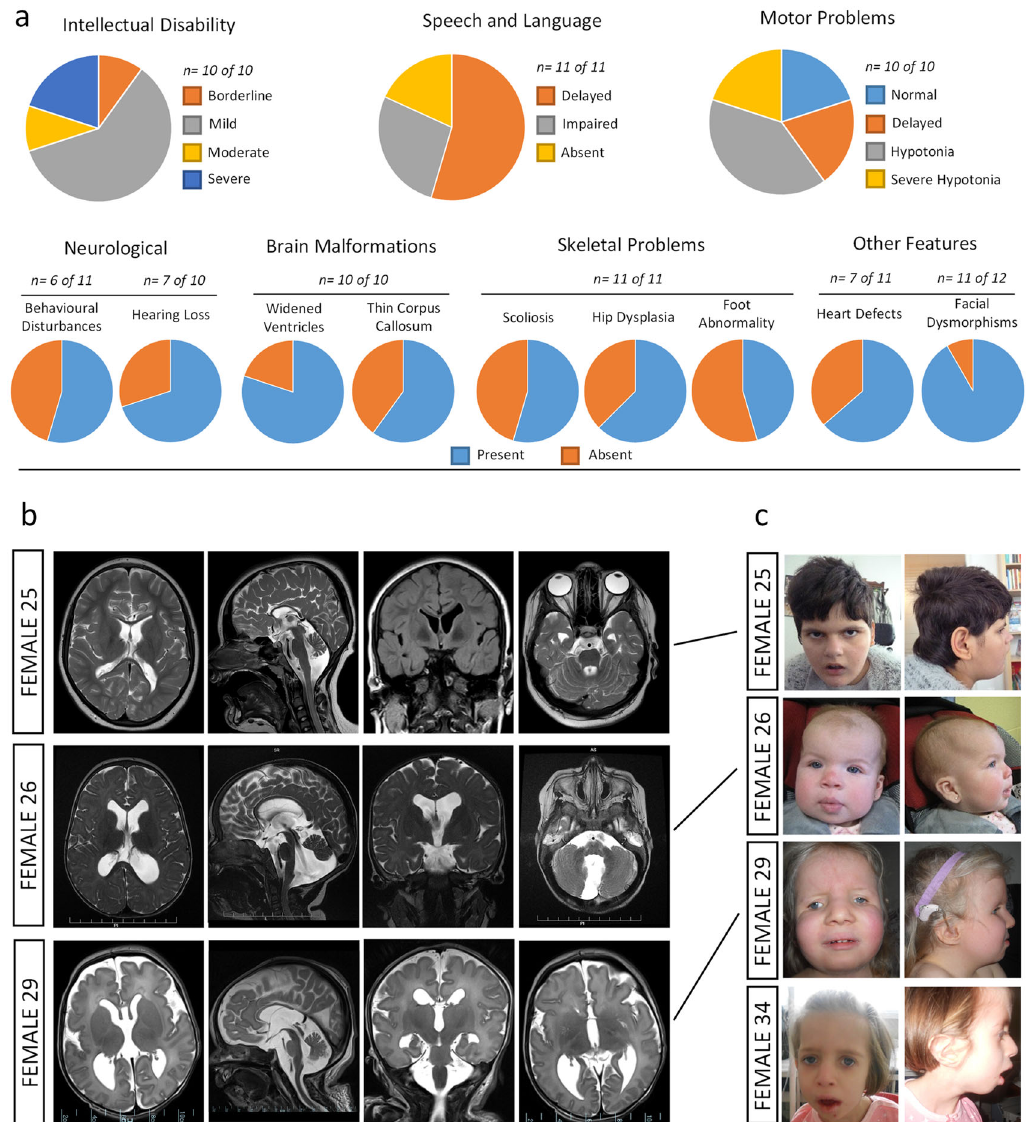
Fig. 4 Phenotypic features of females with USP9X missense and single amino acid deletion variants. a Constellation and frequency of major clinical features. b Magnetic resonance imaging (MRI) of brains of affected individuals. Note prominent extra-axial spaces in all, hypoplastic corpus callosum in Females 25 and 29, optic nerve atrophy and in Female 25, Dandy Walker malformation and Blake ’ s pouch cyst in Female 26, and ventriculomegaly of the 3rd and 4th ventricles in Female 29. c Images of affected females showing facial dysmorphisms, with common features including deep-set eyes, telecanthus, blepharophimosis, a broad nasal tip with wide alae and short collumnella, and low set and dysplastic ears. Written consent was obtained for the publication of